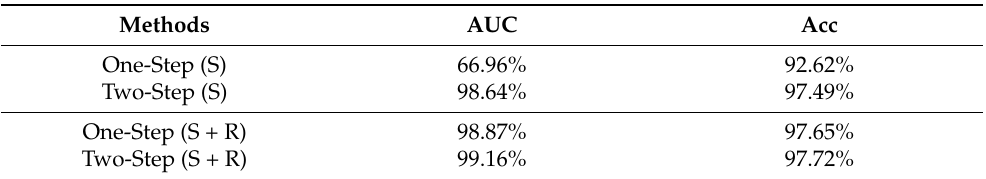
Table 7. A comparison of the vessel segmentation results on the CHASE_DB1 dataset between the one-step and the two-step